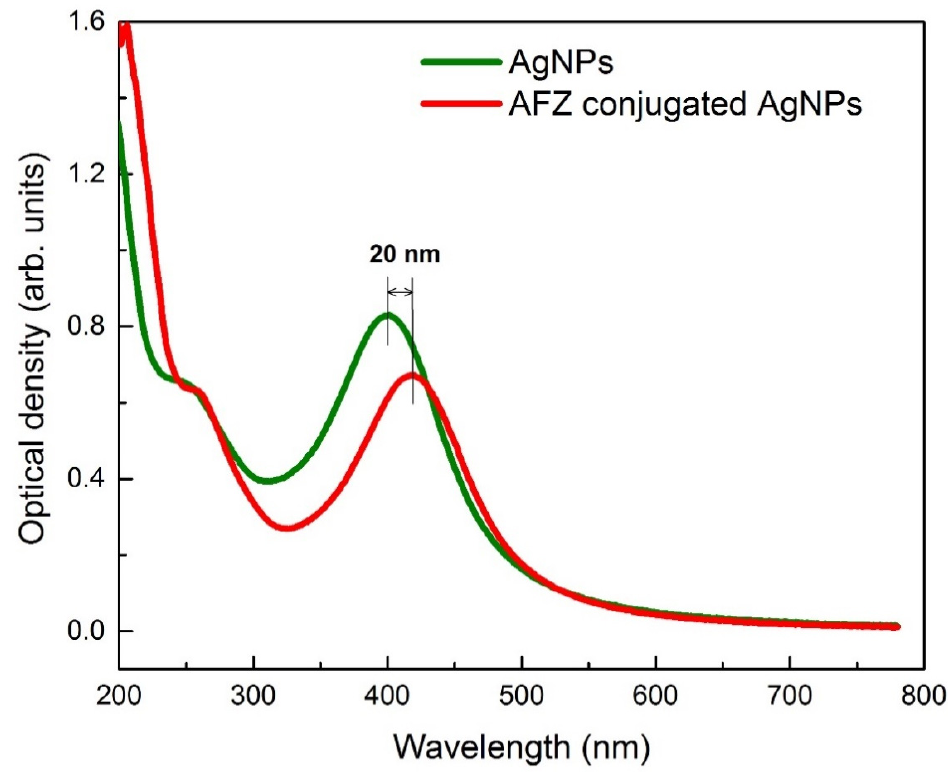
Figure 1. Absorption spectra of the AgNPs and afzelechin conjugated AgNPs. The afzelechin conjugation causes a 20 nm shift in the absorption spectrum.